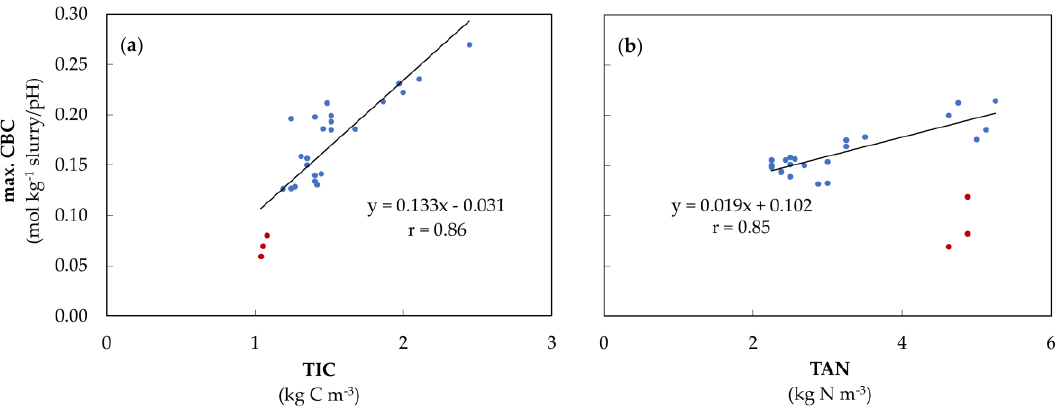
Figure 4. ( a ) Maximum CBC during acidification in HCO 3 − bu ff er depending on the TIC content of the di ff erent slurries (sow slurry in red dots) in week 0 and 8 (n = 26); ( b ) Maximum CBC during titration from pH value 2.5 to 11.5 in the NH 3 bu ff er depending on the TAN content of the di ff erent slurries in week 0 and 8, sow slurry of week 0 (red dots) was excluded from the calculation of the regression line here (n = 23).